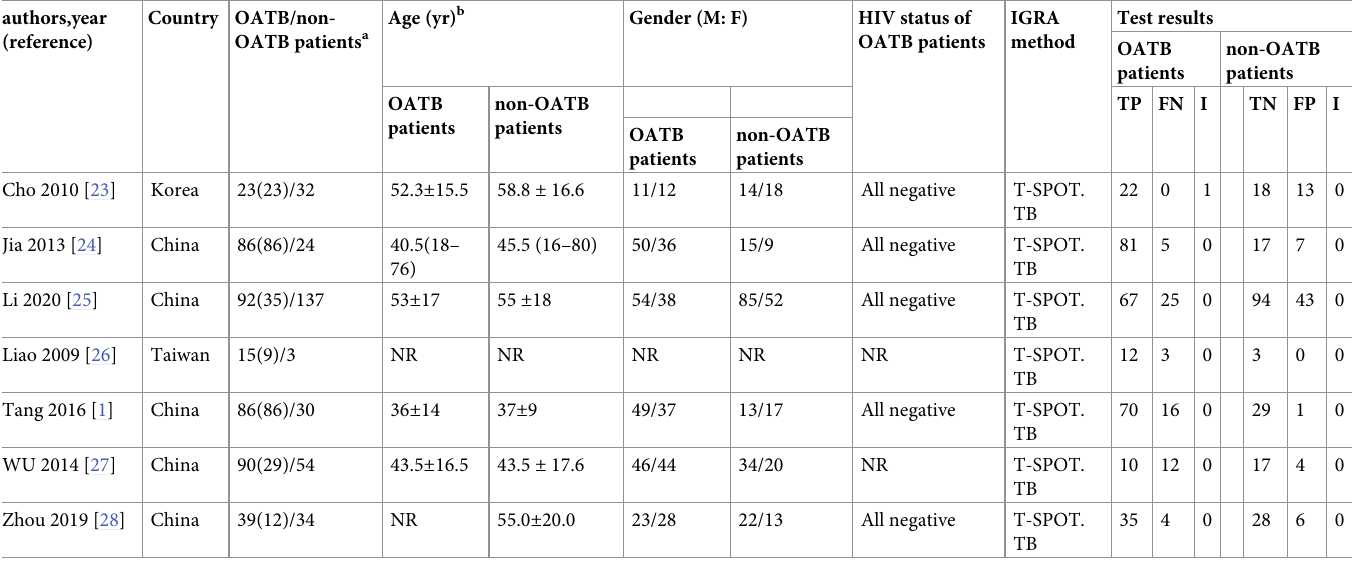
Table 1. Summary characteristics of studies included in the meta-analysis.